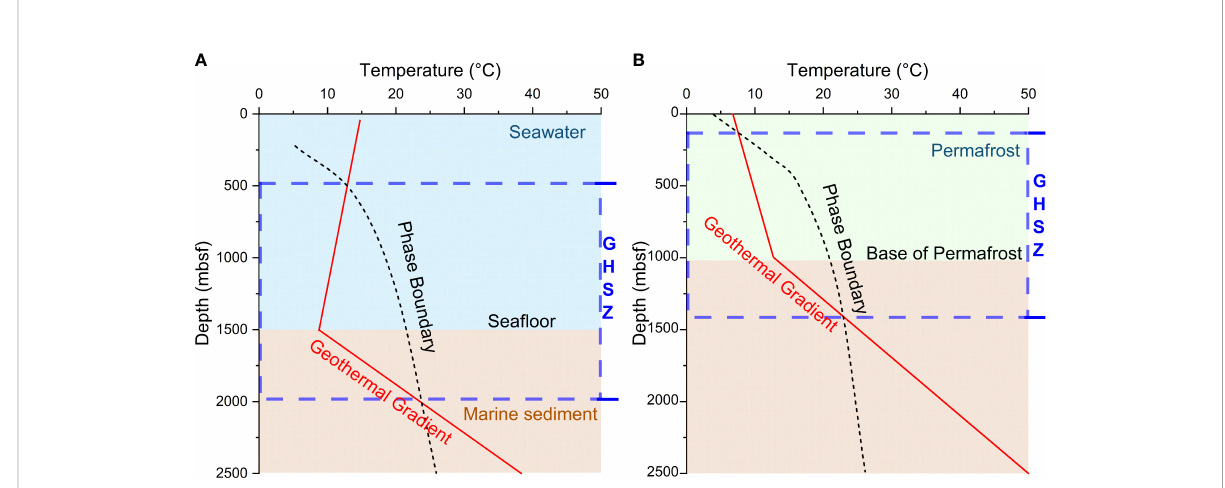
FIGURE 2 Gas hydrate stability zone (GHSZ) for gas hydrates in (A) marine environment and (B) permafrost environment, modi fi ed from (Chen and Merey,